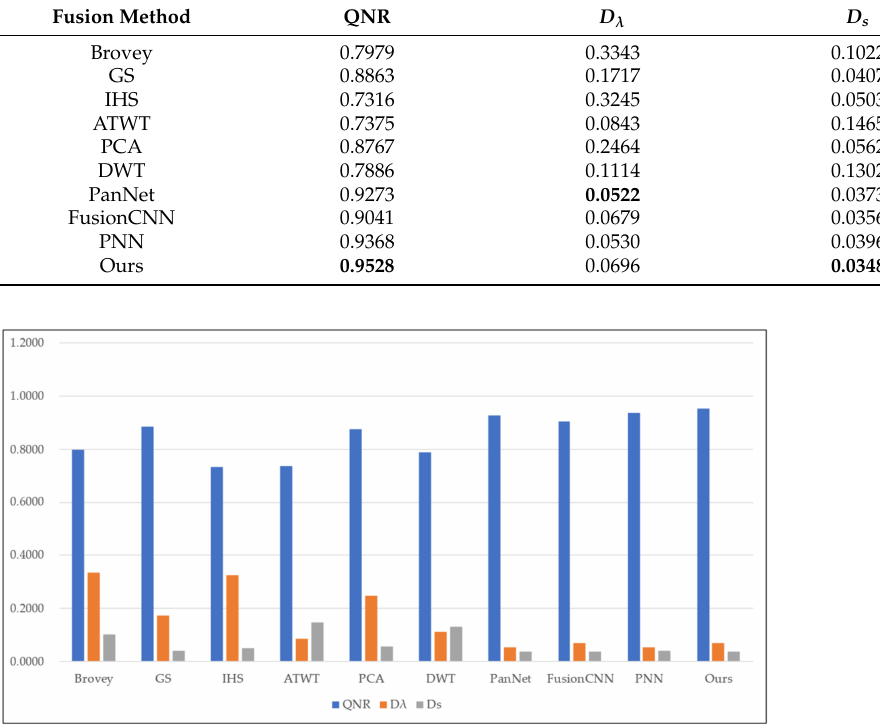
Figure 14. Histogram result of the third group of evaluation